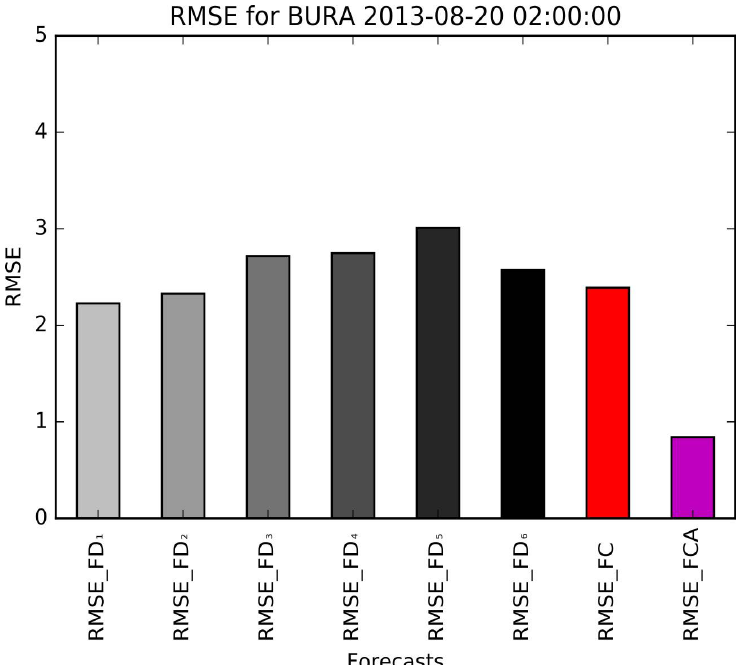
Figure 12. An example of improved accuracy: the final correction (RMSE_FCA) has better accuracy than any of the previous